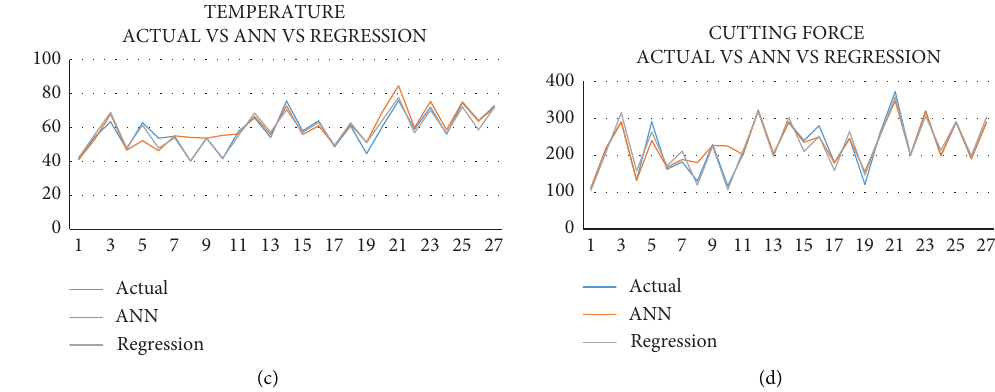
Figure 7: (a) Actual vs. regression vs. ANN on Ra. (b) Actual vs. regression vs. ANN on MRR. (c) Actual vs. regression vs. ANN on temperature. (d) Actual vs. regression vs. ANN on cutting